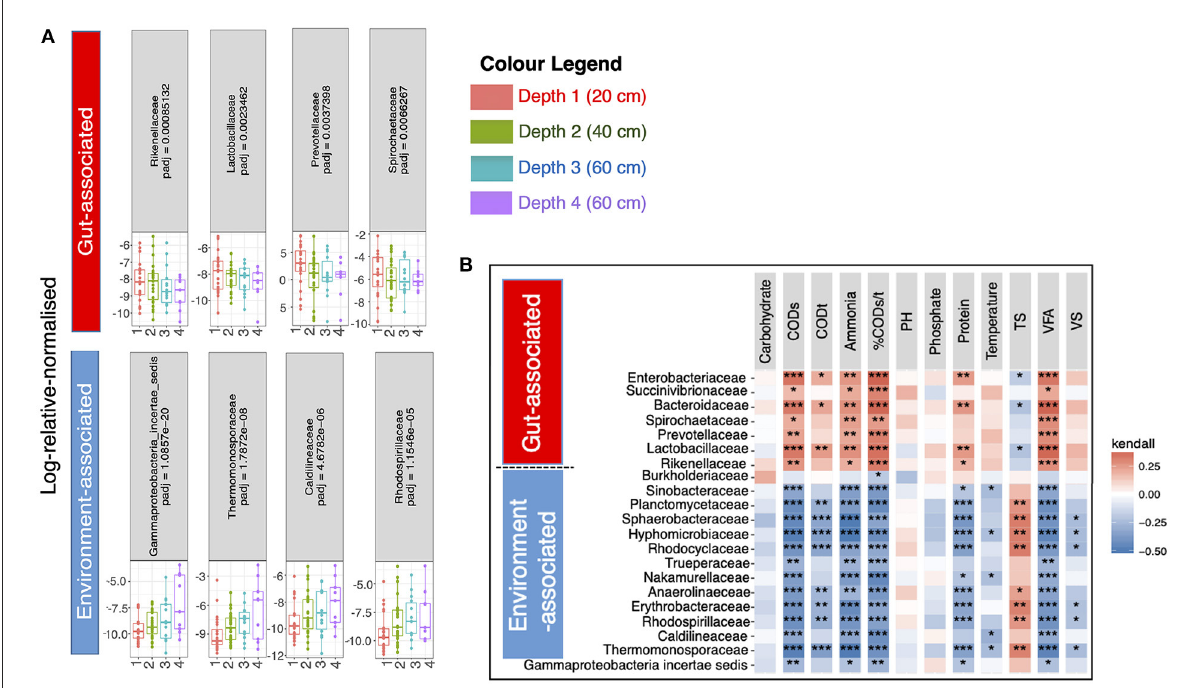
FIGURE4 21 families were significantly different (Adjusted p -values ≤ 0.05) between the four pit latrine sample depth layers (Depth 1 = 20cm, Depth 2 = 40cm, Depth 3 = 60cm, and Depth 4 = 80cm). In (A) four families that were predominantly gut-associated species ( n = 7) are drawn in the top row whilst the families that increased in proportional abundance with greater depth, and four families that were predominantly environment-associated, ( n = 14) are drawn in the bottom row. The remaining familes are shown in Supplementary Figure 3. Correlation plots (B) of the full 21 families for samples at Depth 1 (20cm), Depth 2 (20cm), Depth 3 (60cm), and Depth 4 (80cm) with the recorded environmental factors are drawn top right. For this calculation we took the relative proportions of the abundance data before calculating the Kendall correlation. The p -values for a single environmental factor (column) were adjusted for multiple tests using the Benjamini and Hochberg (1995) correction method. The adjusted significant p -values are represented as *0.01 ≤ p < 0.05; **0.05 ≤ p < 0.001; and *** p ≤ 0.001 in top right panel. Depth 1 = 20cm, Depth 2 = 40cm, Depth 3 = 60cm, and Depth 4 =